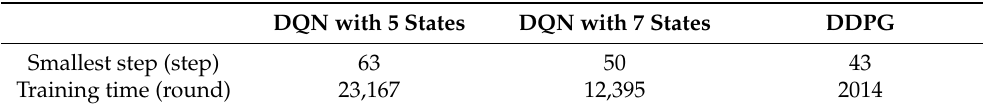
Table 2. The statistics for the first scenario, including smallest number of steps to reach the goal and the training time required to find the smallest number of steps for reaching the goal.